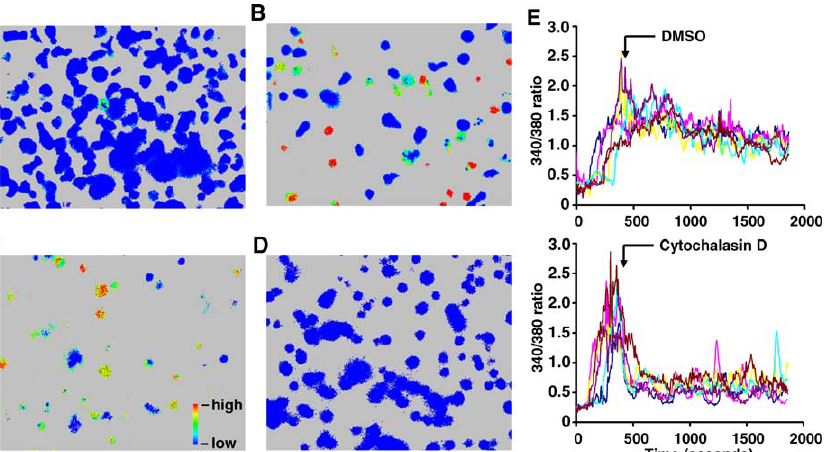
Figure 5. TCR Triggering by Monomeric Agonist pMHC Requires T Cell Adhesion to the Bilayer and Intact Actin Cytoskeletal Function (A and B) Lipid bilayers containing 5 mol% DOPE-biotin were anchored with monovalent (IEk-MCC)-SA. The bilayers were then used to stimulate T cells directly (A) or were further anchored with (ICAM-1) 2 -SA (B) before adding T cells. Bilayers anchored with only (ICAM-1-bio) 2 -SA did not induce T cell calcium flux. (C and D) A layer of CH27 cells pulsed for 1 h with 1 l M MCC-FITC was attached on cover glasses coated with poly- L -lysine. Fura-2 AM–pulsed AD10 T cells treated with 10 l M cytochalasin D for 1 h (D), or untreated AD10 T cells (C) were introduced, and calcium flux was monitored. (E) Similar to (C), except that 10 l M cytochalasin D (or DMSO as control) was introduced after T cell calcium flux reached peak levels.